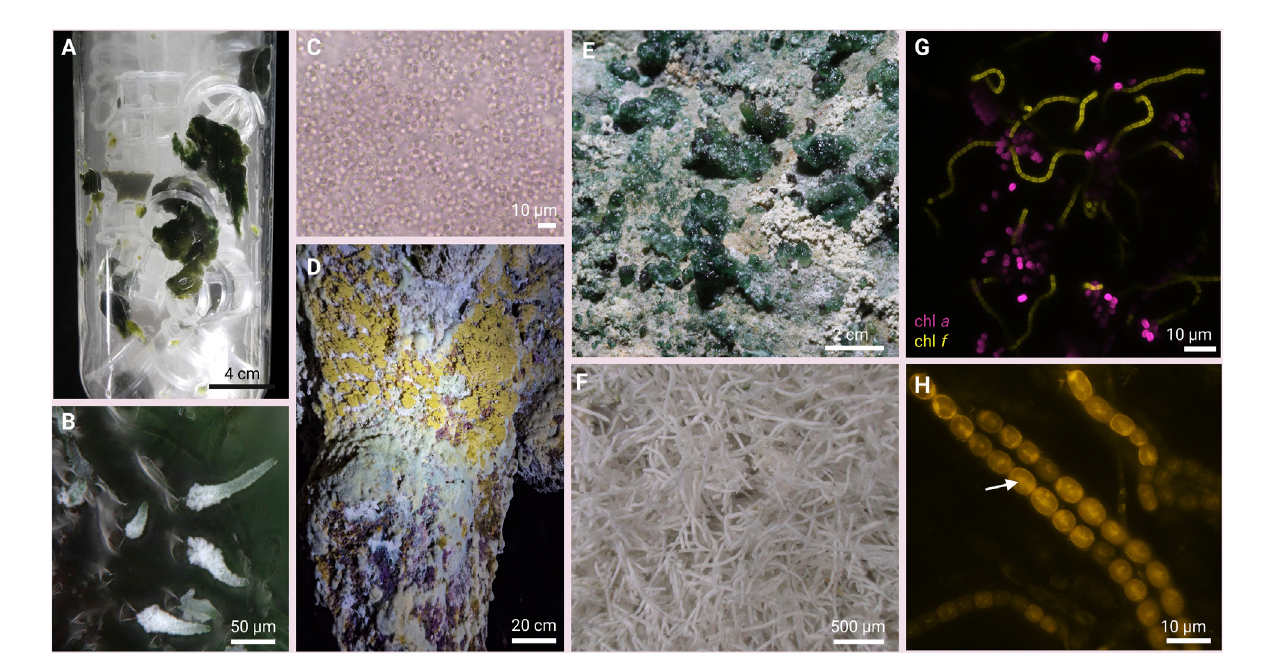
FIGURE 2 Cyanobacteria from the cave environment. (A) emerse photobioreactor (ePBR) fi lled with biocarriers as substrate on which cyanobacteria grow. The reactor is aerated with aerosol as the medium. (B) isolated Scytonema sp. with calci fi ed tip fi laments under laboratory conditions. (C) microscopy of Gloeobacter sp. (D, E) natural cyanobacteria dominated bio fi lms from caves. (F) calci fi ed natural sheaths of Geitleria sp. (G) confocal laser scanning microscopy (CLSM) showing cyanobacteria with emission wavelengths characteristic for chl d / f (yellow; 725 – 750 nm) and chl a and phycobilisomes (magenta; 650 – 700 nm). (H) Nile red staining and fl uorescence of Nostoc sp. Isolated from the cave bio fi lms showing PHB-rich granules